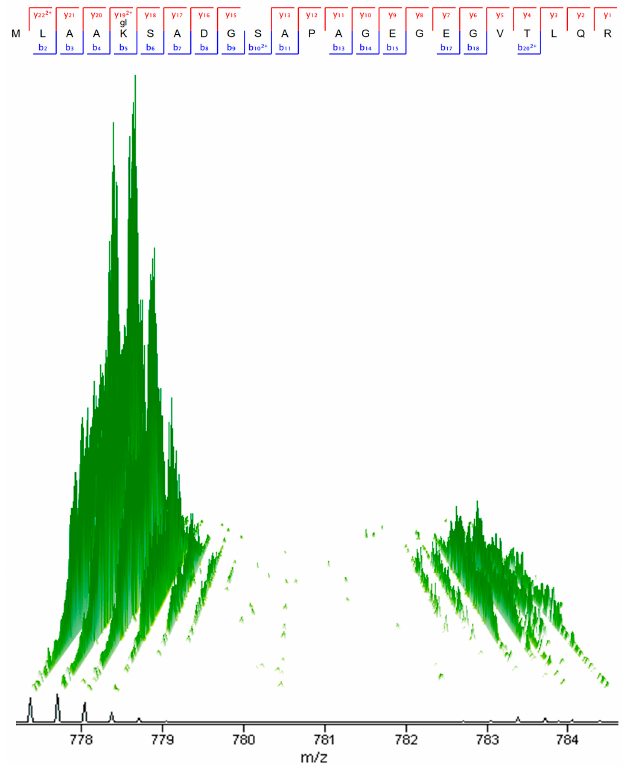
Figure 1. A stable isotope labeling with amino acids in cell culture (SILAC) pair of an ubiquitinated solute carrier (SLC) transporter peptide. Isotopic patterns ( 13 C) of the precursor mass spectrometry (MS1) peaks of the peptides (MLAAK (Ubi) SADGSAPAGEGEGVTLQR, m / z 777.72 and 783.72, charge 3 + , MS score 195.36) from SLC7A5 are displayed in three dimensions (3D) from the SILAC pairs of unlabeled 143B.TK- (peaks on the left) and 13 C 15 N labeled ρ 0 cells (peaks on the right). Labelled lysine (Lys8) and arginine (Arg10) in ρ 0 resulted in a mass shift of 6 Da. The identified MS 2 y- and b ion series of the peptide is indicated above the 3D peaks. The 32-fold peak volume decrease of the heavy peak indicates the tremendous de-ubiquitination in ρ 0 cells.